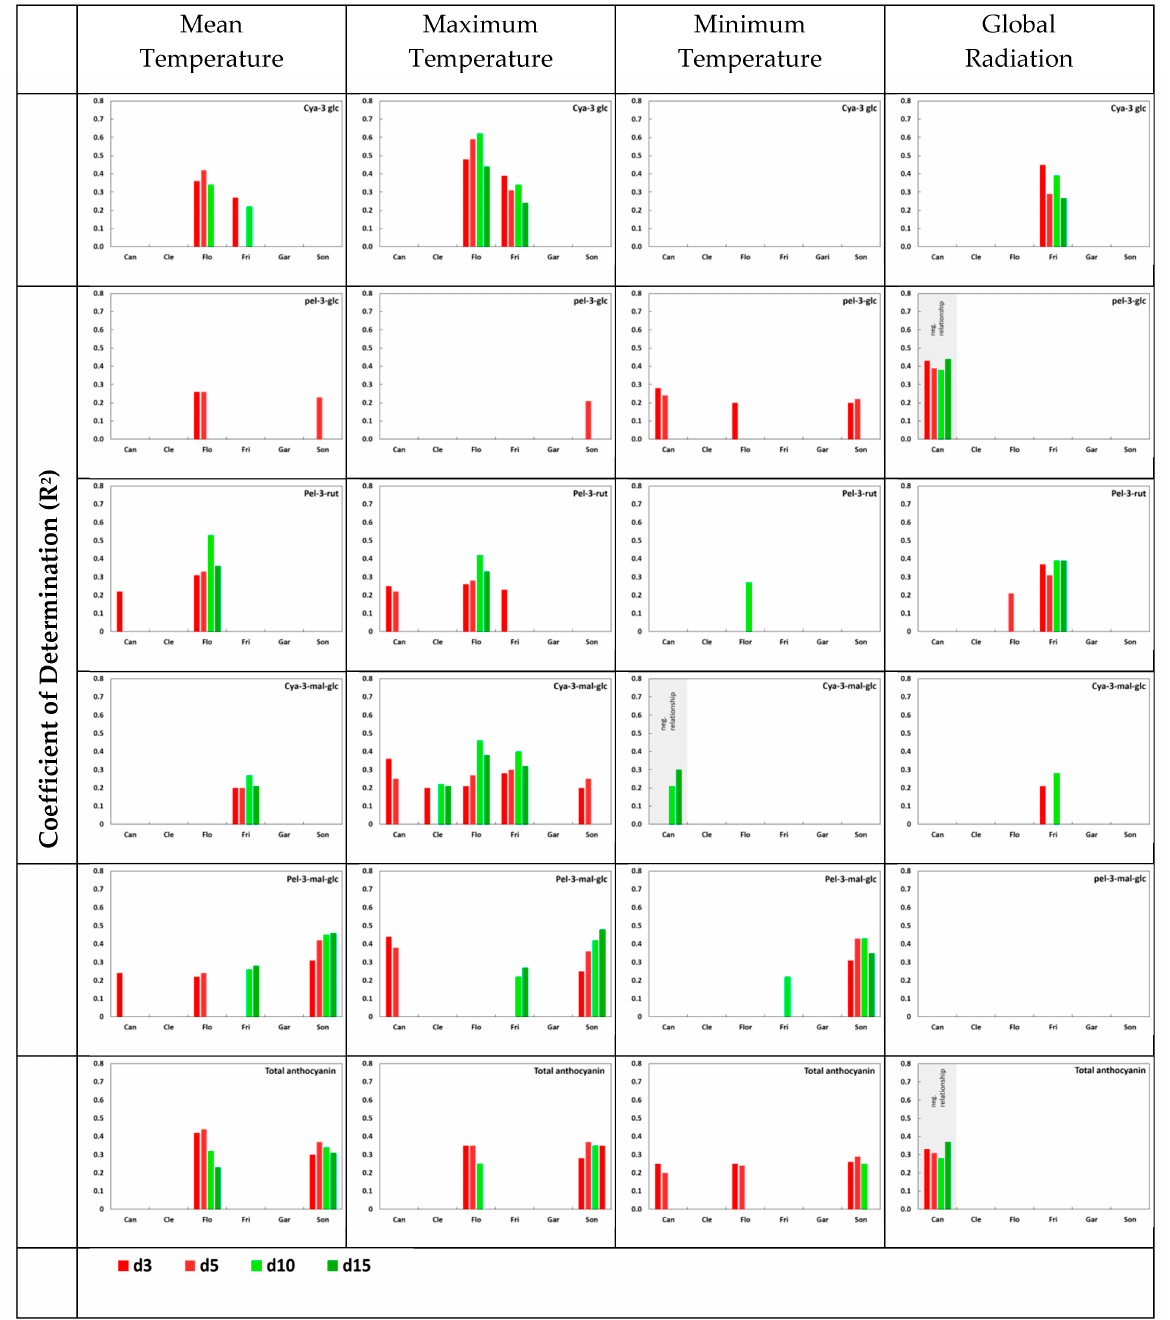
Figure 5. Coefficient of determinations (R 2 ) between cya-3-glc, pel-3-glc, pel-3-rut, cya-3-mal-glc, ple-3-mal-glc and total anthocyanin (shown top to bottom) and the environmental factors’ mean temperature (T mean ), maximum temperature (T max ), minimum temperature (T min ) and global radiation accumulated for 3, 5, 10 and 15 days (3d, 5d, 10d and 15d) before sampling of the berries to be analyzed for each cultivar ‘Candonga’ (Can), ‘Clery’ (Cle), ‘Florence’ (Flo), ‘Frida’ (Fri), ‘Gariguette’ (Gar) and ‘Sonata’ (Son), shown left to right. Cultivars with no data (blank) indicate the observed correlation between different anthocyanin components, and mean, maximum, minimum temperatures and global radiation were statistically insignificant.